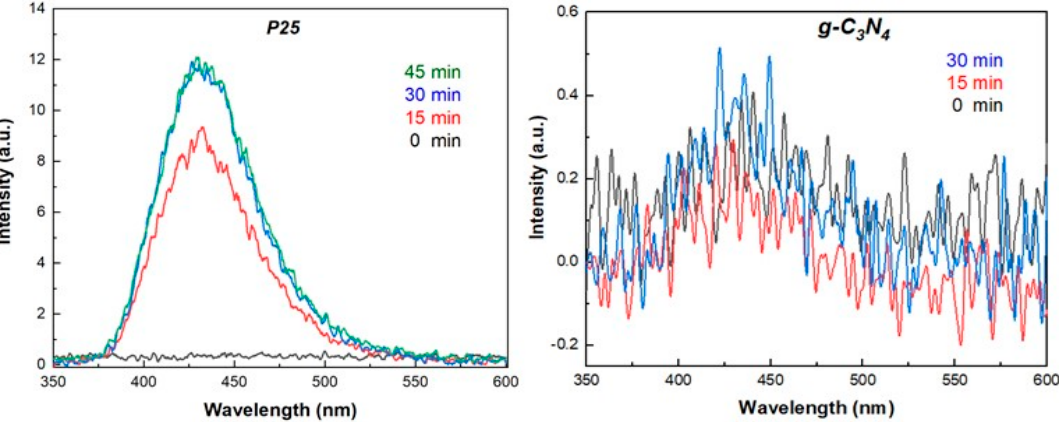
Figure 2. Fluorescence spectra intensity of hydroxy-terephthalic acid (OHTA) formation by TiO 2 and g-C 3 N 4 , ((catalyst) = 100 mg L − 1 ; I = 500 Wm − 2 ).